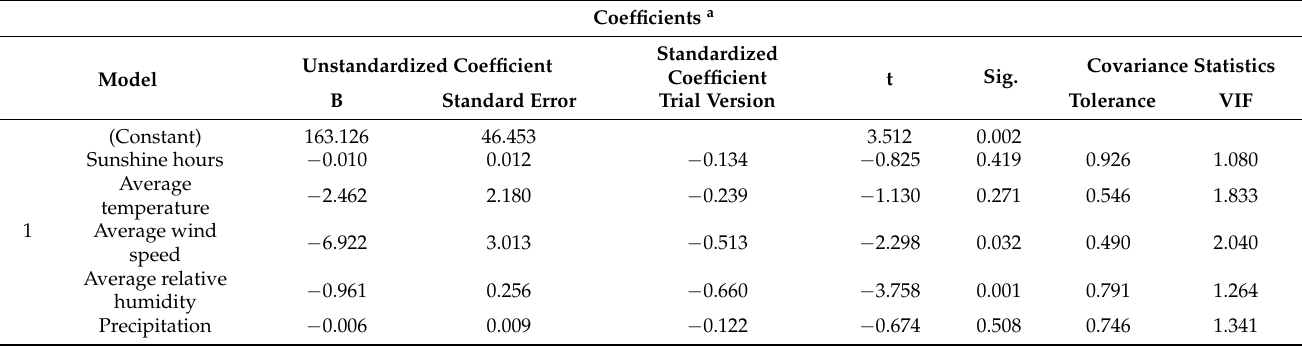
Table 7. Table of